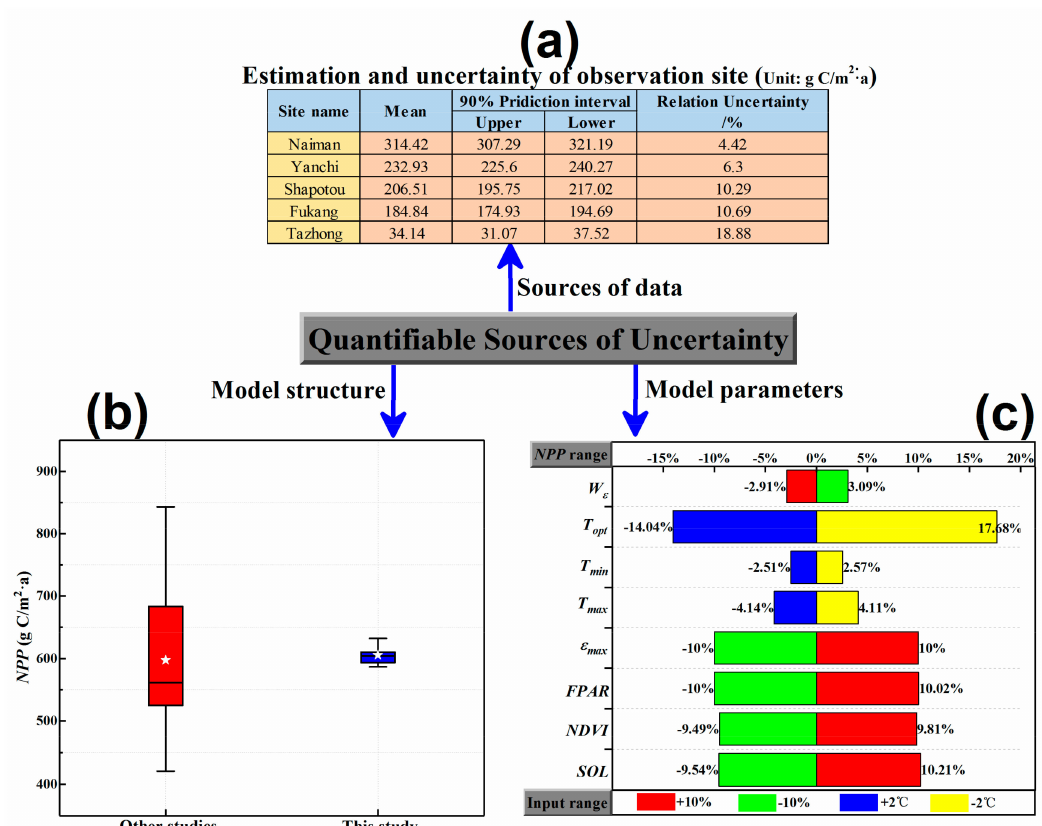
Figure 9. Analysis of uncertainty based on the CASA model. ( a ) the uncertainty based on observation site; ( b ) the results of this study were compared with other studies; ( c ) uncertainty of model